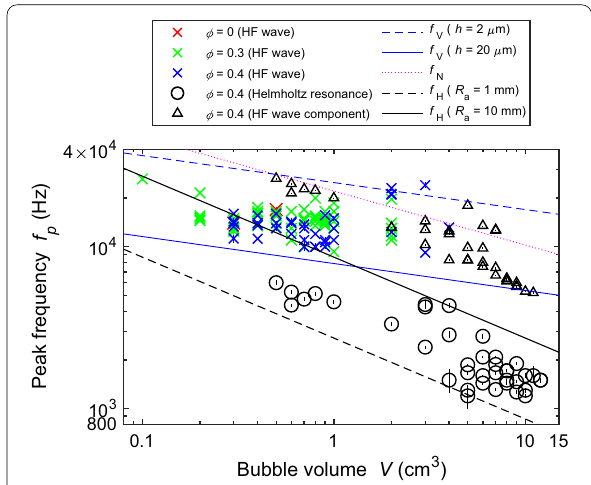
Fig. 12 Bubble volume V dependence of the peak frequency f p (with errors) of the airwaves. An HF wave is excited by a hemispherical cap bubble. Helmholtz resonance and the HF wave component are excited together by a bubble which bursts when it partially protrudes above the surface. f V , f N , and f H are calculated from Eqs.(9), (10), and (11) respectively, using h and R a values given in the legend (see text for details). A hemispherical cap bubble was assumed to calculate f V , f f l / R N . For a partially protruding bubble with V becomes b = 1 (Eq. (7)), smaller by a factor of ∼ 0.8 . ρ of φ = 0.4 suspension was used